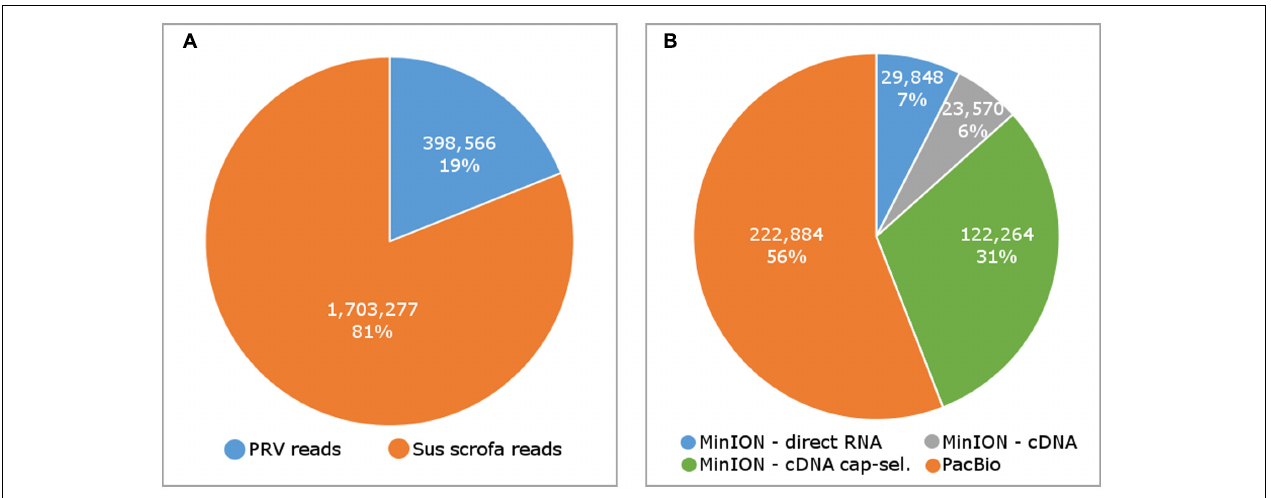
FIGURE 2 | The number of sequencing reads mapping to the pseudorabies virus (PRV) and host (Sus scrofa) genome (A) , and the number of reads by sequencing methods (B) .